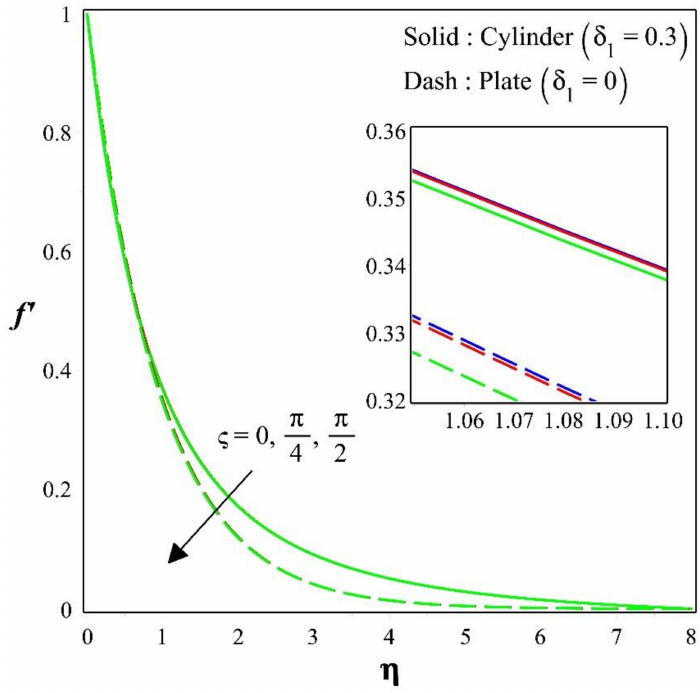
Figure 6. The role of inclined angle on velocity profile (keeping P m = γ 1 = 0.1, φ 1 = φ 2 = φ 3 = 0.01 & H = 0.5). SS